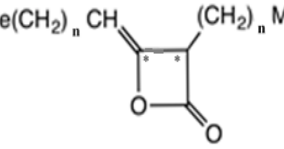
Figure 13. Molecular structure of Alkyl ketene dimers (AKDs).